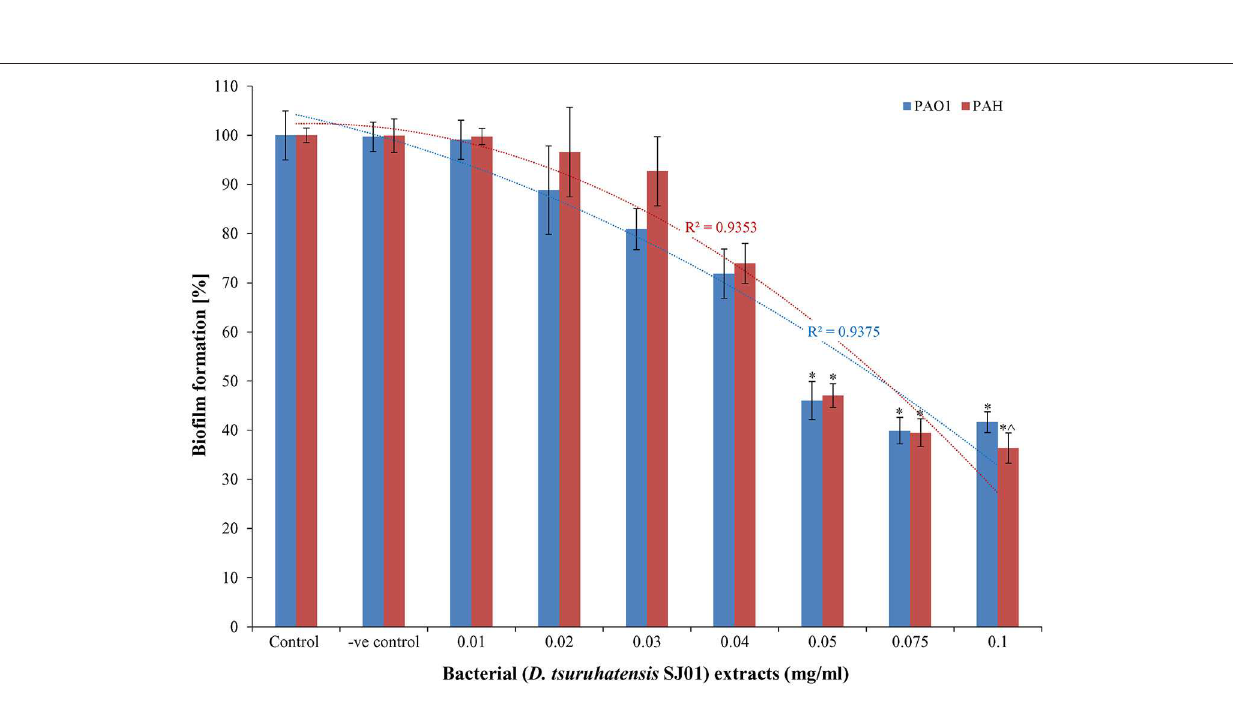
Frontiers in Cellular and Infection Microbiology | www.frontiersin.org